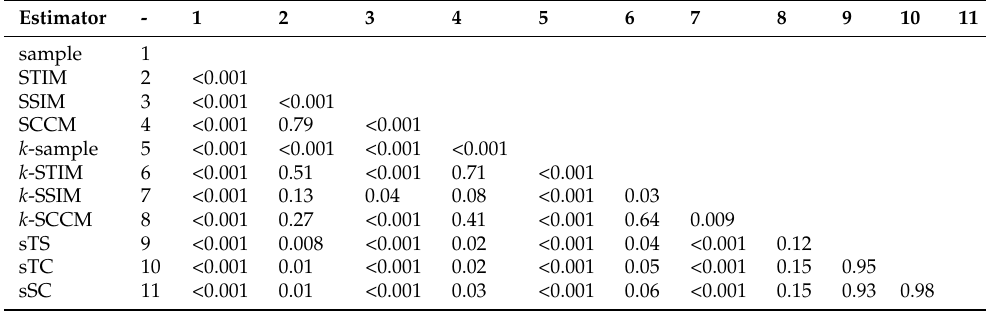
Table A3. p -Value of the portfolio turnover for each pair of covariance estimators in Table 2. Estimator